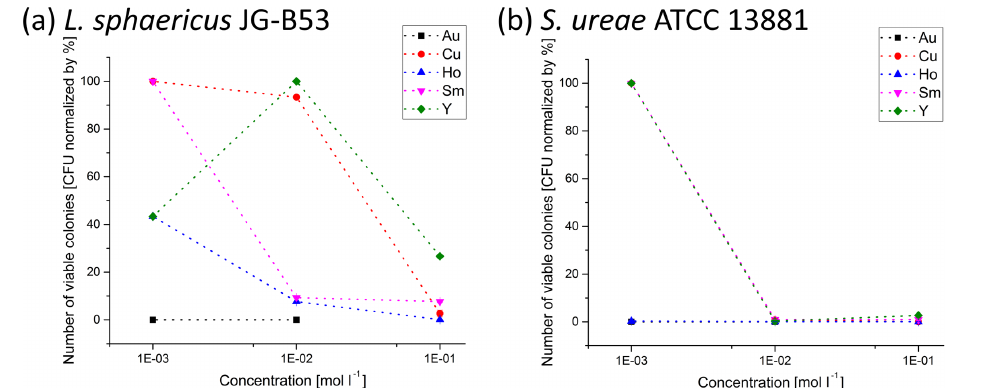
Figure 4. Metal tolerance of (a) L. sphaericus JG-B53 and (b) S. ureae ATCC 13881 for different metal salts and concentrations determined for growth on agar plates after 2 days of incubation. The colonies were counted after 5 days and normalized to the CFU count of reference plates without metal salts.